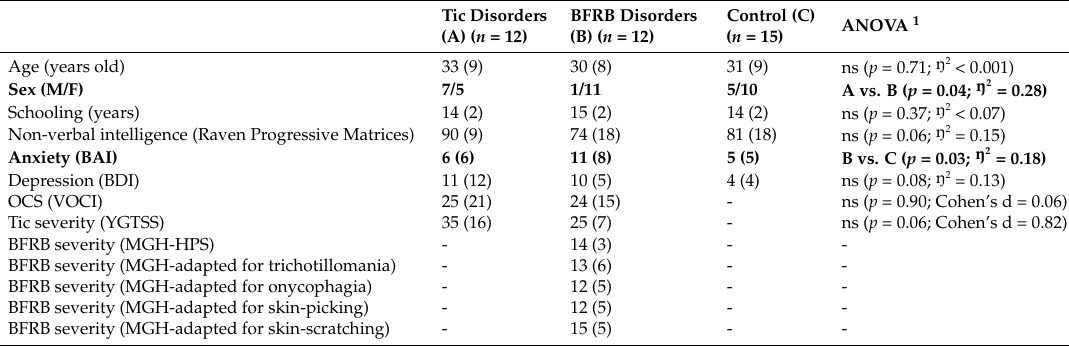
Table 1. Sociodemographic and clinical characteristics. Means (standard deviations).